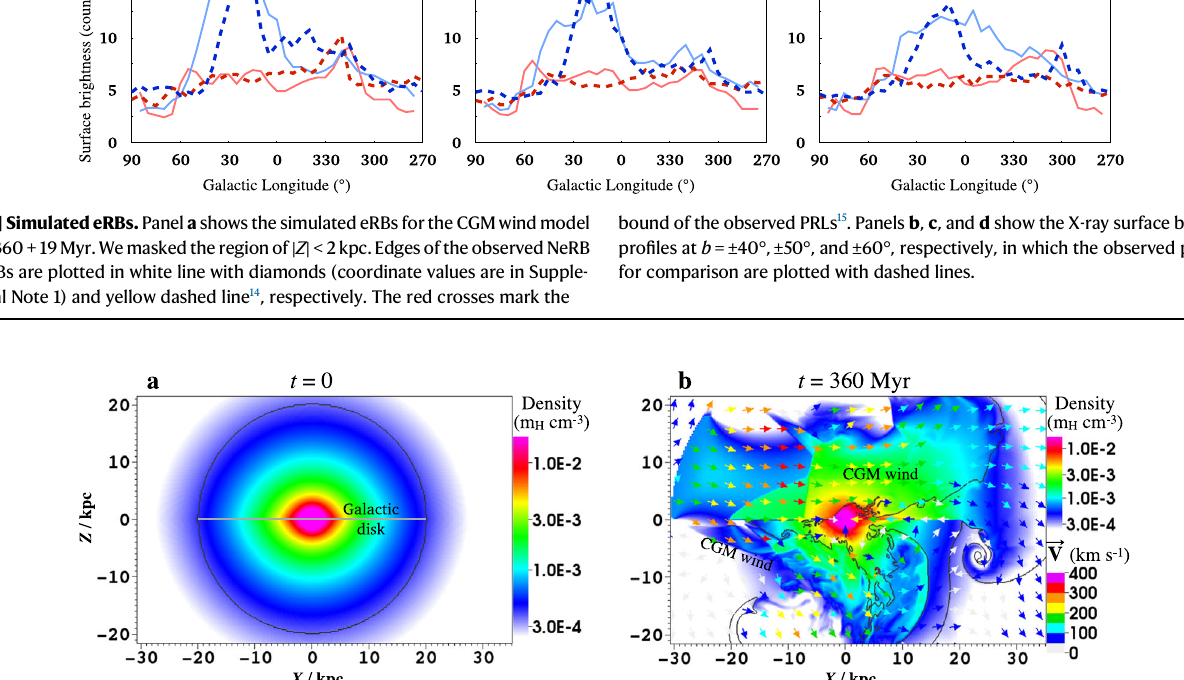
densityandmetalabundanceinnorthernandsouthernhalosarequitedifferent.In the northern halo, the materials at Z ≳ 3 kpc are incoming CGM wind. In the southern halo, the region of ∣ Z ∣≲ 4 kpc is almost unaffected, and the initial halo medium even stretches to Z ≃ − 20 kpc in the leeward